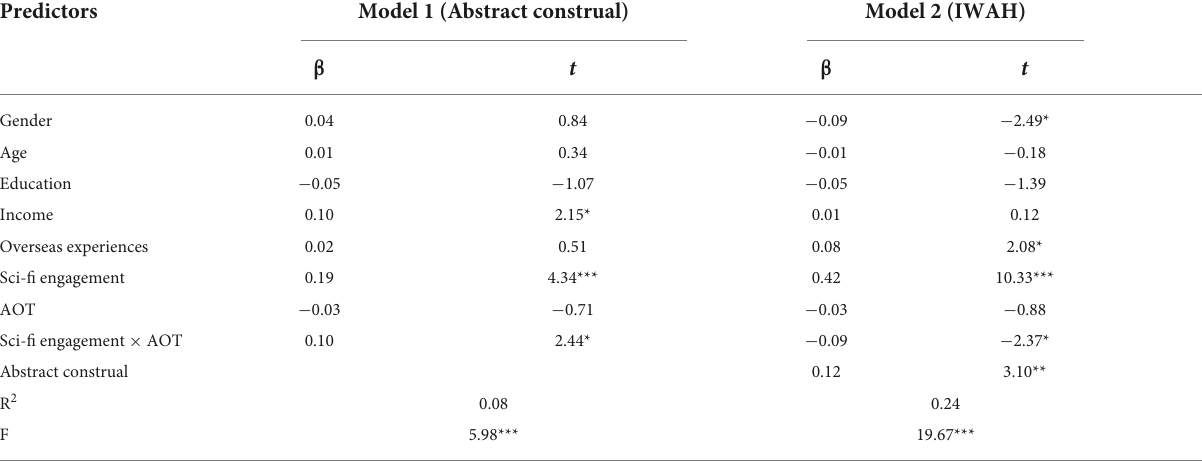
TABLE 5 Testing the moderated mediation effect of actively open-minded thinking (AOT).